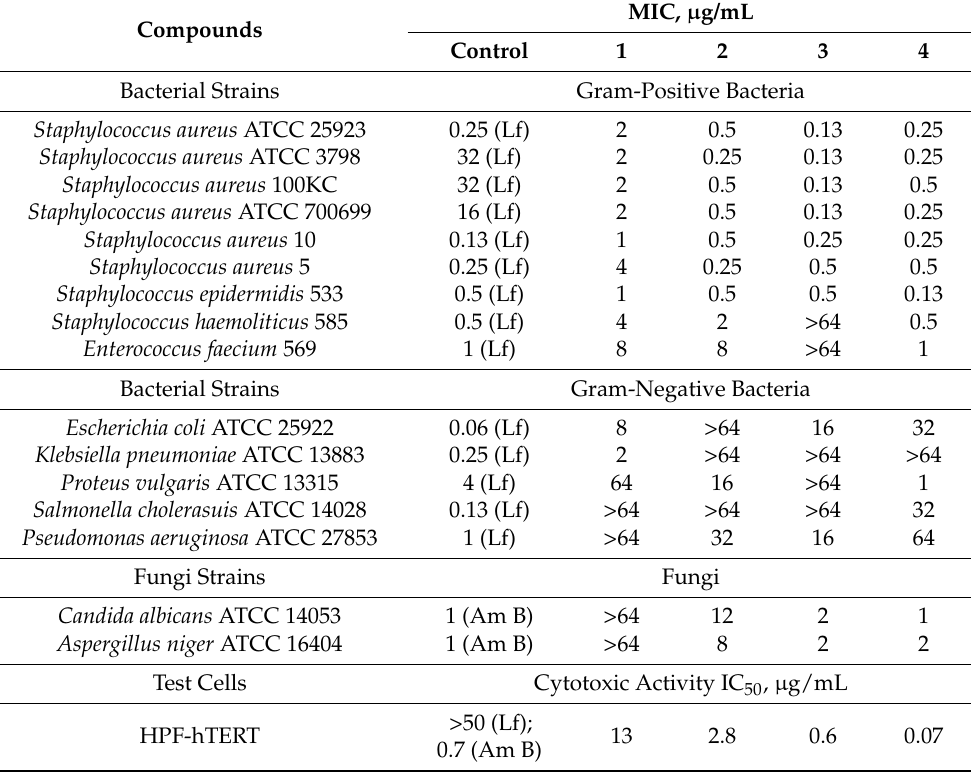
Table 1. Antimicrobial activity of compounds in